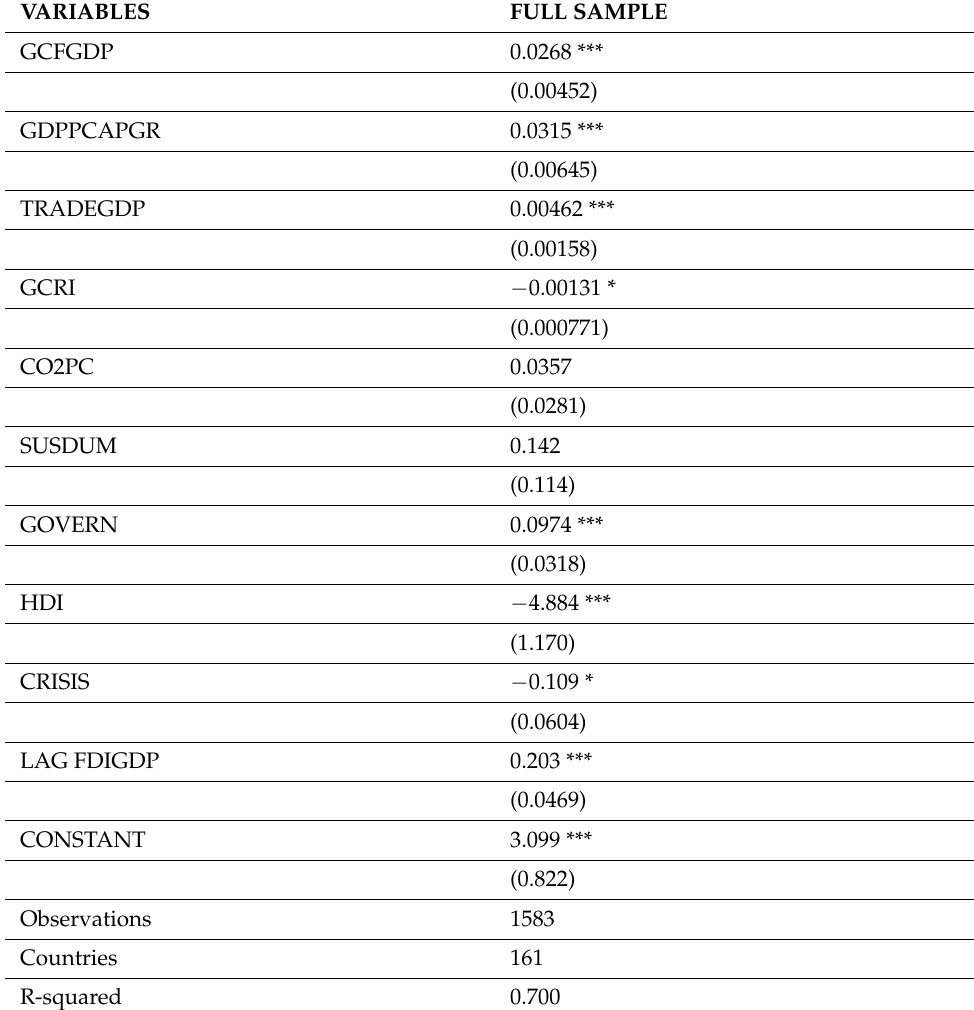
Table 3. FDI Inflows as a percentage of GDP: results for full